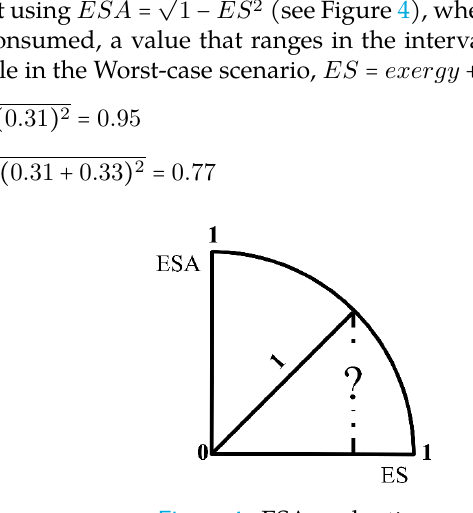
Figure 4: ESA evaluation